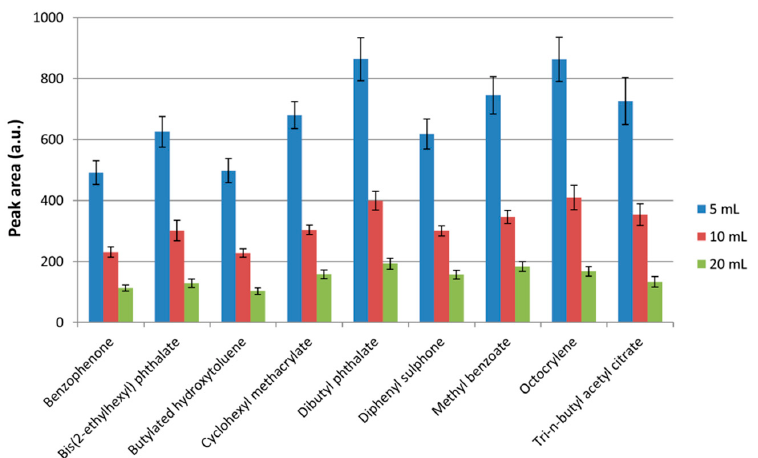
Figure 3. Study of the extraction solvent volume. Experimental conditions: extraction solvent, n-hexane; ionic strength, 5% w / v of NaCl; extraction time, 60 s. Bars in the graph represent the mean value of three replicates ± standard deviation.